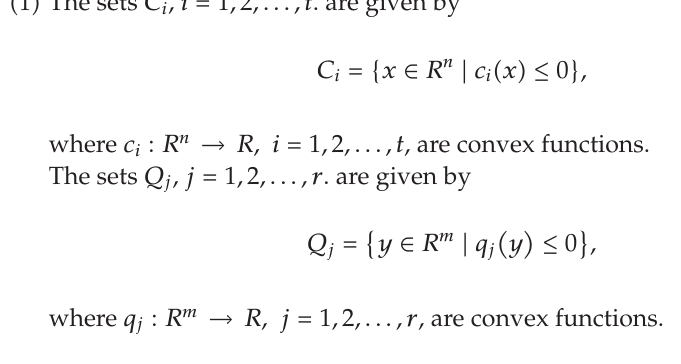
Algorithm 3.1 need not estimate the largest eigenvalue of the matrix A T A , and